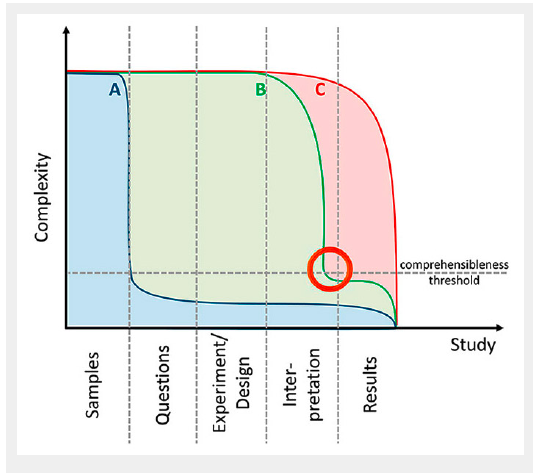
Complexity of the conventional “hypothesis-driven” approach (A) compared with “hypothesis-free” study approaches (B & C). Most of the published metabolomics studies resemble study type C: differences are determined and principal component analysis (PCA) score plots are frequently drawn. But since complexity is not really reduced, interpreting the data and answering the study questions is difficult and sometimes impossible. Study type B includes a complexity reduction step (e.g. variable/model selection, see orange circle) and thereby facilitates interpretation. Elaborate statistics are necessary to perform this reduction, but they are unavoidable since the complexity of the information contained in the “-omics” data usually exceeds human comprehension